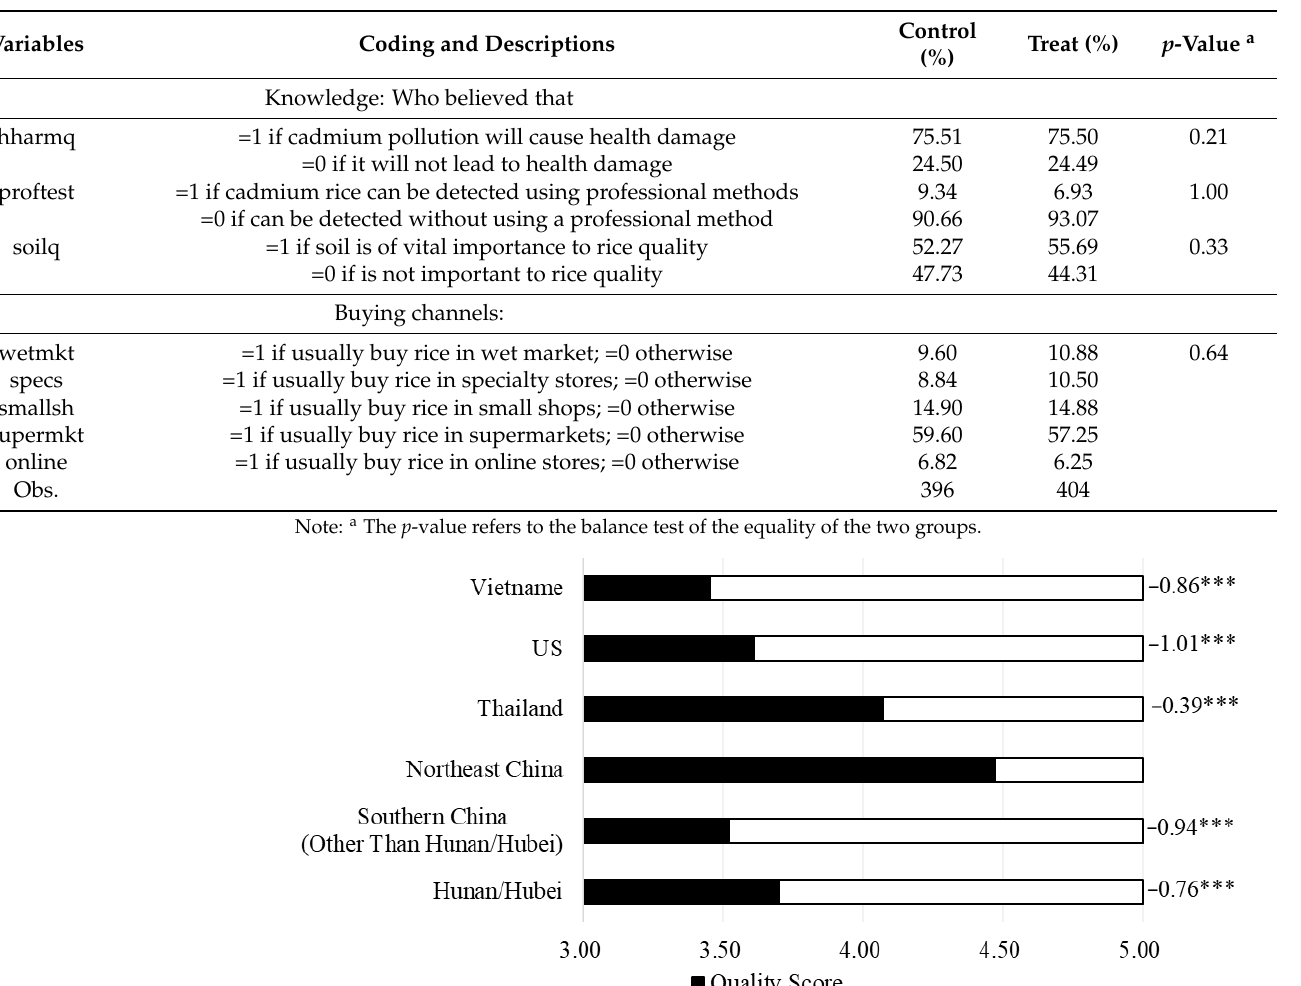
Table 3. Proportion of knowledge levels and buying channels.